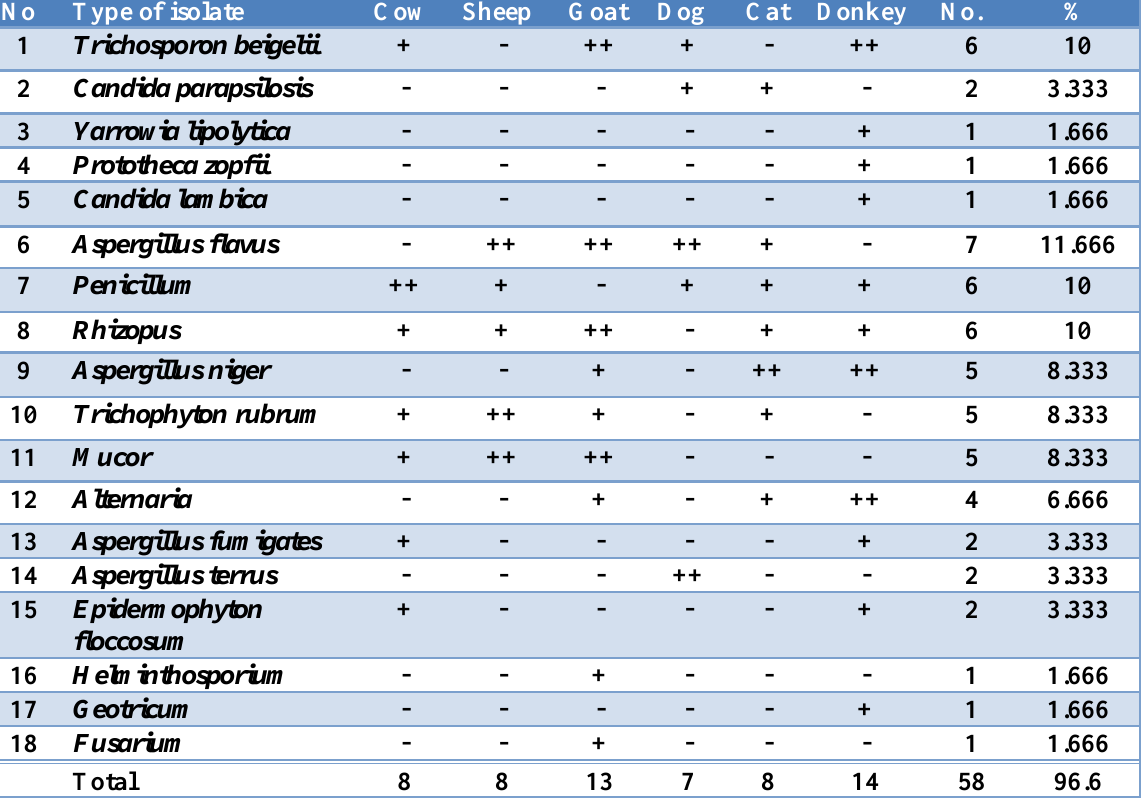
Table, 2: Show the types of isolates and the type of